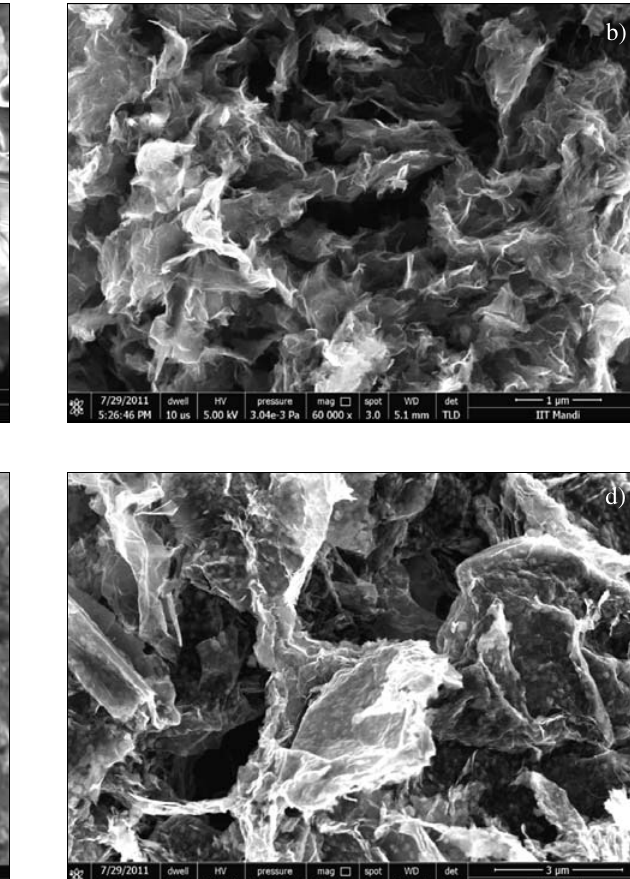
O and (d) NiFe 2 4